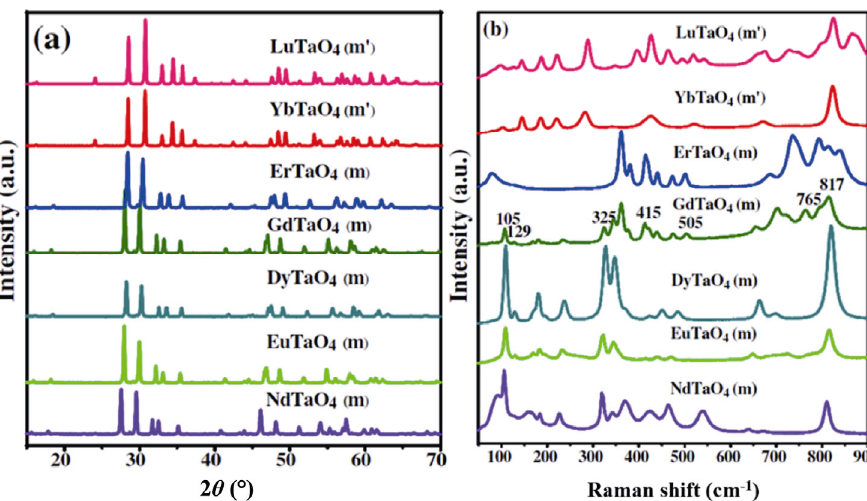
Fig. 12 (a) XRD patterns and ICDD PDF data of RETaO 4 (RE = Nd, Eu, Gd, Dy, Er, Yb, and Lu) ceramics and (b) room-temperature Raman spectra. Reproduced with permission from Ref. [84], © Acta Materialia Inc. 2016.